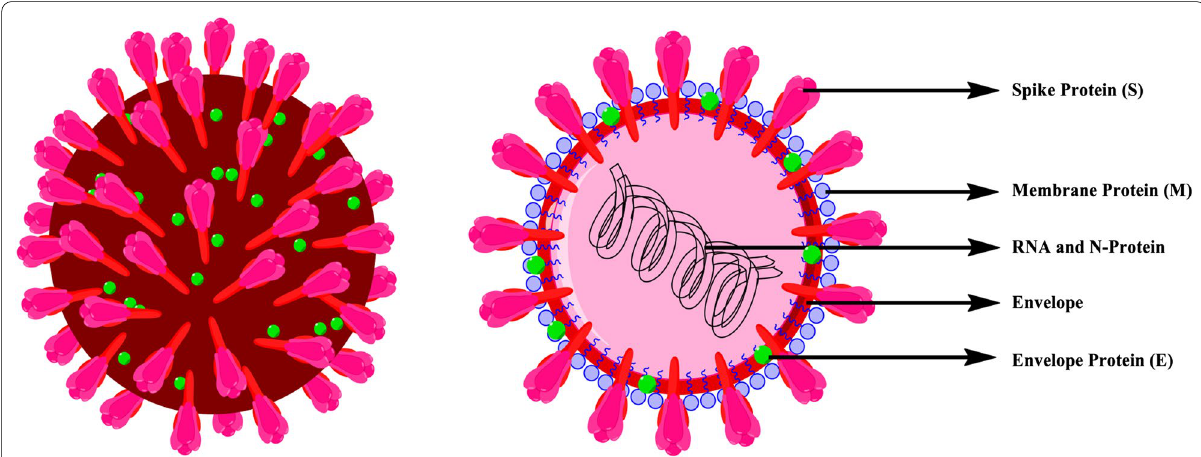
Fig. 1 The structure of novel coronavirus